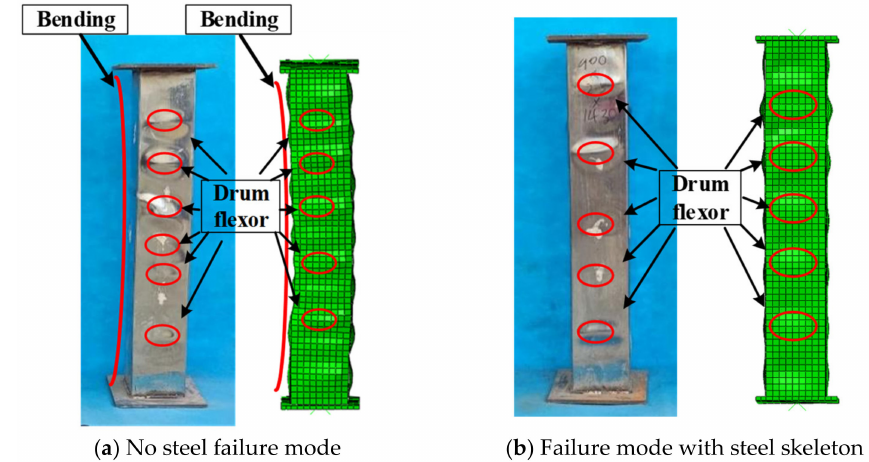
Figure 8. Comparison of failure modes of